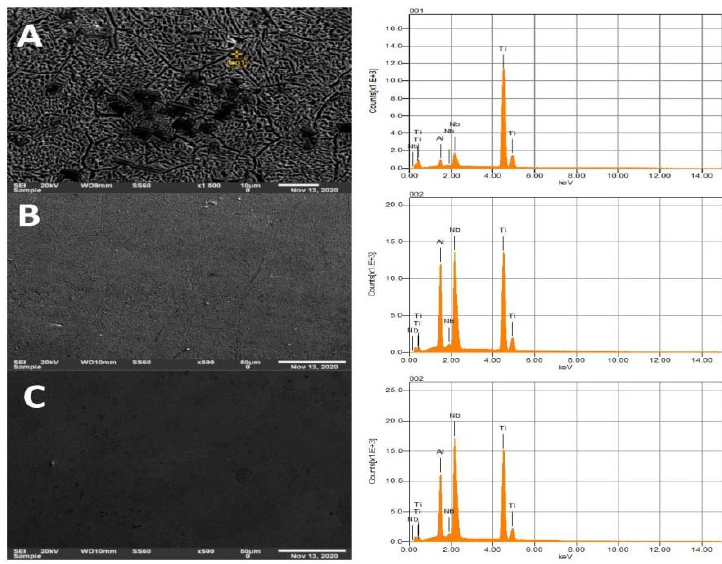
Figure 3. EDS images of synthesized Ti-Al-xNb; ( A ) A, ( B ) A1 and ( C ) A3. Table 3. Elemental composition (at%) and actual density of the developed alloys. Elements in Atomic %